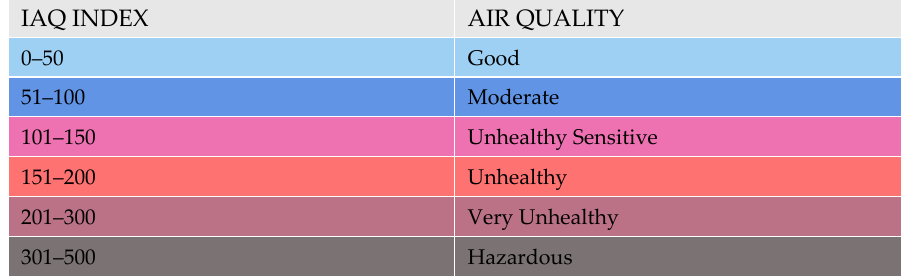
Figure 8. IAQ “wellness” bands indicated in the estimation of IAQ value of Figure